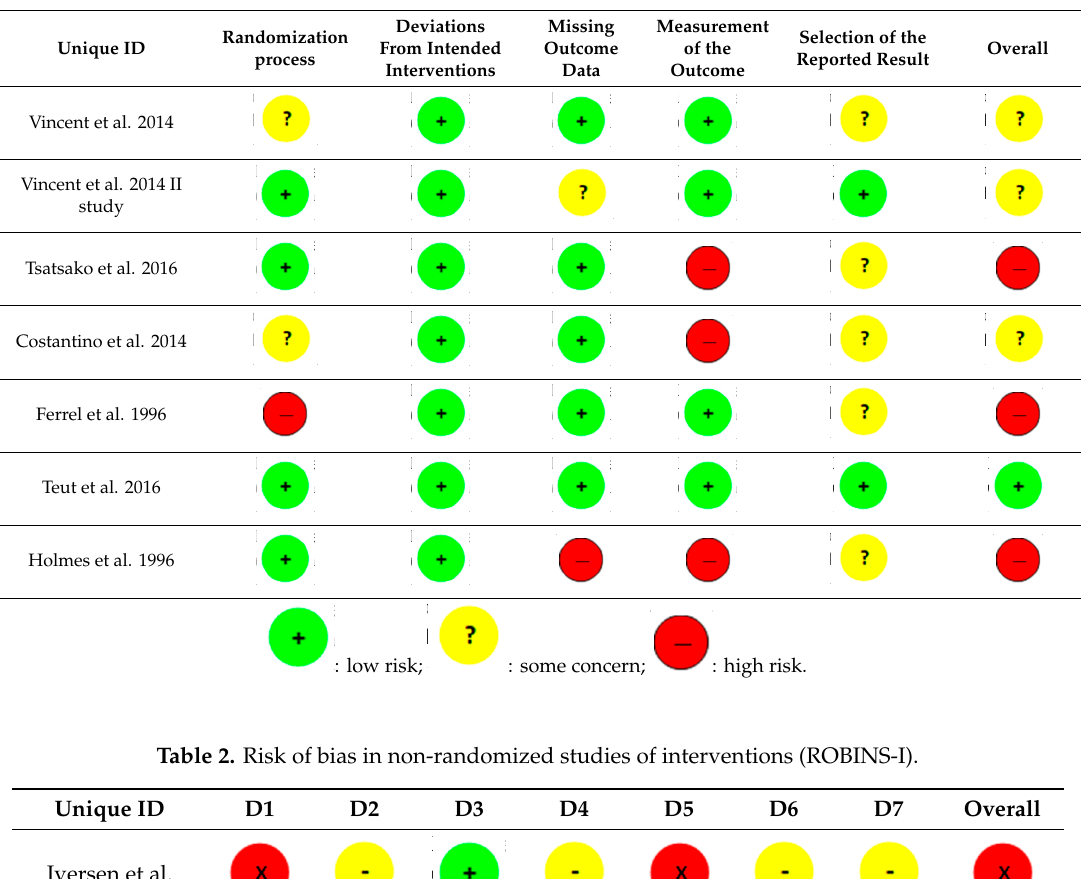
Table 2. Risk of bias in non-randomized studies of interventions (ROBINS-I).